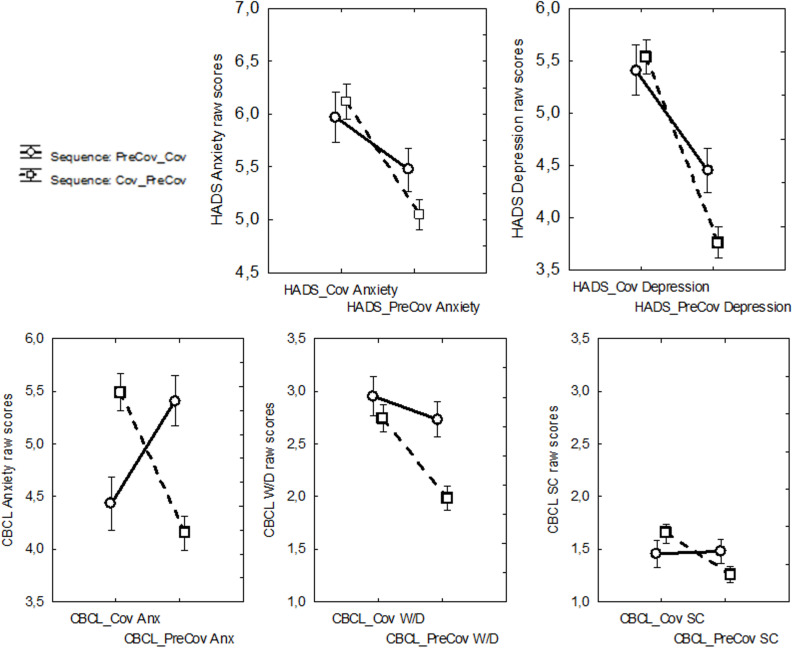
Time (the two repetitions of a questionnaire in the Cov – with reference to the Covid-19 health emergency- and Pre_Cov - with reference to the period preceding the start of the Covid-19 outbreak- conditions) × Sequence (PreCov_Cov and Cov_PreCov) interaction obtained from mixed model repeated-measure ANOVAs for the measures (1) HADS (Hospital Anxiety and Depression) Anxiety, (2) HADS Depression, (3) CBCL (Child Behavior Checklist) Anxiety, (4) CBCL Withdrawn/Depressed, and (5) CBCL Somatic Complaints. W/D, withdrawn/depressed; SC, somatic complaints. Error bars indicate standard errors of the means.